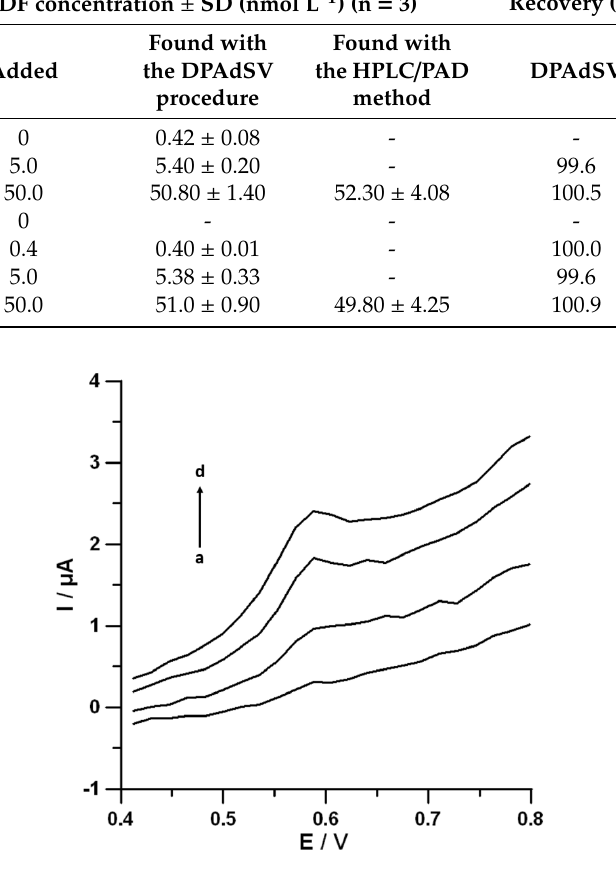
Figure 8. DPAdSV curves recorded at the SPCE/MWCNTs-COOH surface in the course of DF determination in 5 ml Vistula river water sample #1 without DF (a) and with 0.5 nmol L −1 (b), 1.0 (c) nmol L −1, and 1.5 nmol L −1 (d) of DF. Other conditions are the same as in Figure 7. Table 3. Comparison of electrochemical methods for the determination of DF.